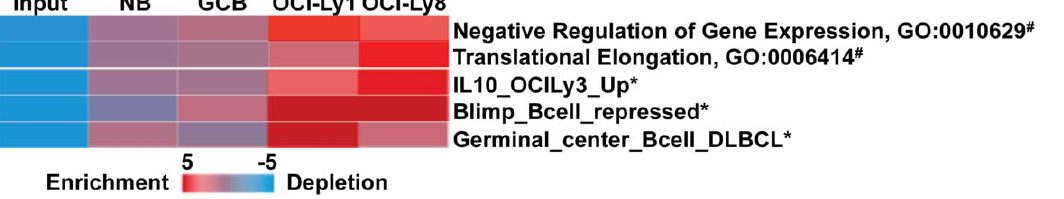
Figure 2. Novel promoter SNVs target important B cell genes in DLBCL. iPAGE analysis using Gene Ontology database ( # ) [43] or a lymphoid specific gene set database (*) [44] showing strong enrichment of genes that are important for germinal center B cells and DLBCLs contain novel promoter SNVs in OCI-Ly1 and OCI-Ly8 cells. doi:10.1371/journal.pone.0040332.g002 PLoS ONE |